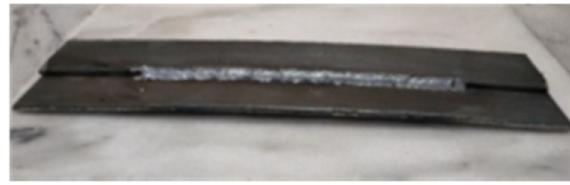
Figure 17. Test sample of optimum weld sequence.